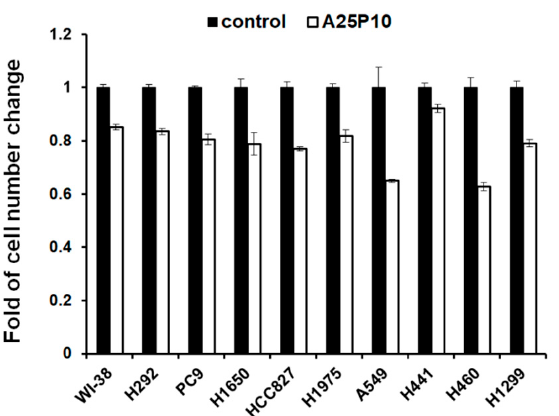
Figure 5. DGAT inhibitors slow down cell growth proliferation. 6000 cells were seeded into the wells of a 96-well plate and treated with DGAT1 and DGAT2 inhibitors A922500 (25 µM) and of a 96-well plate and treated with DGAT1 and DGAT2 inhibitors A922500 (25 µ M) and PF-06424439 PF-06424439 (10 µM) for 72 h. Numbers of cells were measured using methylene blue staining and (10 µ M) for 72 h. Numbers of cells were measured using methylene blue staining and quantitated at quantitated at absorbance at 650 nm. absorbance at 650